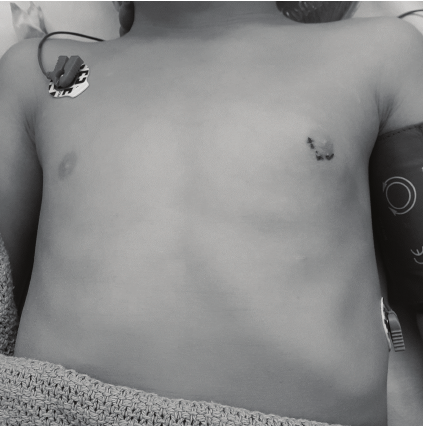
Figure 1: Preoperative photo showing left breast enlargement.